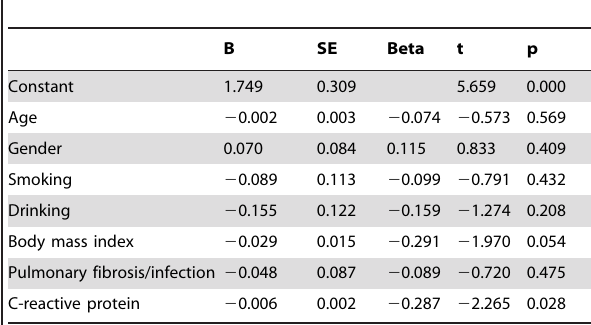
Table 4. The association between C-reactive protein and high-density lipoprotein - cholesterol among untreated patients with early polymyositis in a linear regression